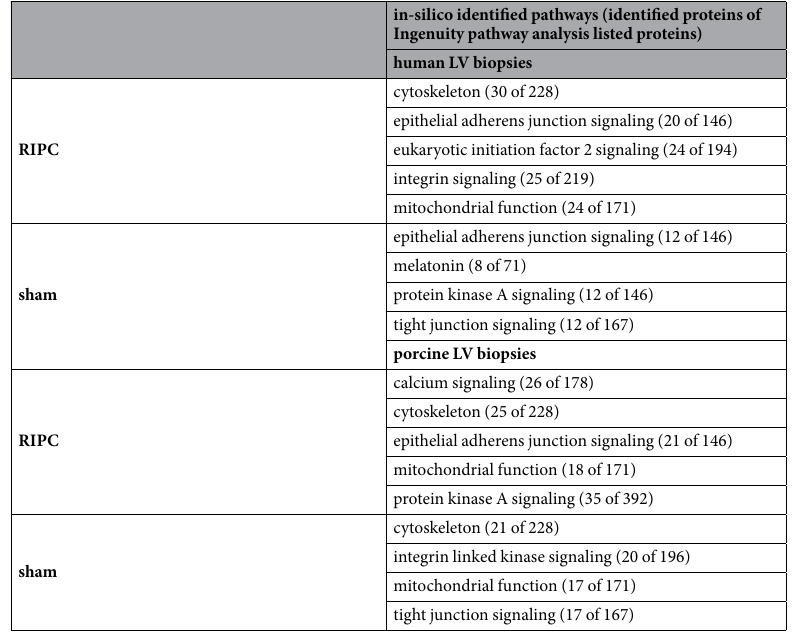
Table 4. In-silico pathway analysis. In-silico pathway analysis was performed with all identified proteins having ≥ 2-fold higher expression/phosphorylation with remote ischemic preconditioning (RIPC) versus with sham in human left ventricular (LV) biopsies taken at early reperfusion after cardioplegic ischemic arrest and in porcine LV biopsies taken at early reperfusion after coronary occlusion using Ingenuity pathway analysis